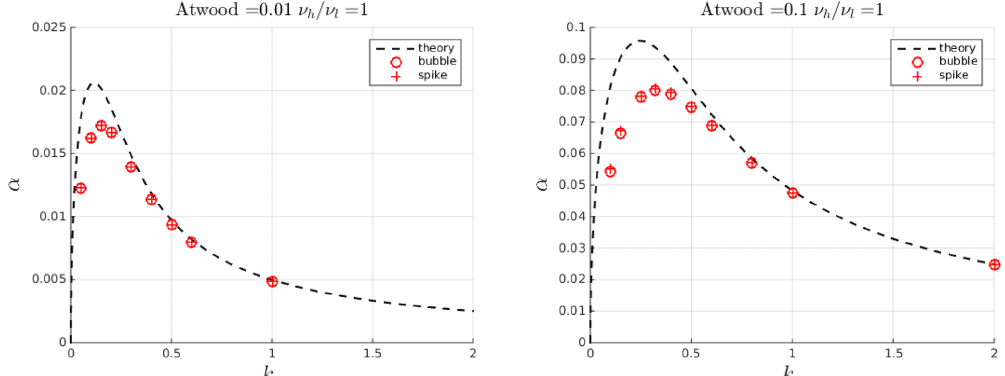
Figure 3. Comparison between computed growth rates (symbols) of the Rayleigh–Taylor instability in the linear regime obtained with the solver interFoam and theoretical ones (dashed line). Bubble growth rates are computed by tracking the position of the interface with respect to the central axis of the domain, while spike growth rates are computed with respect to one of the lateral boundaries.